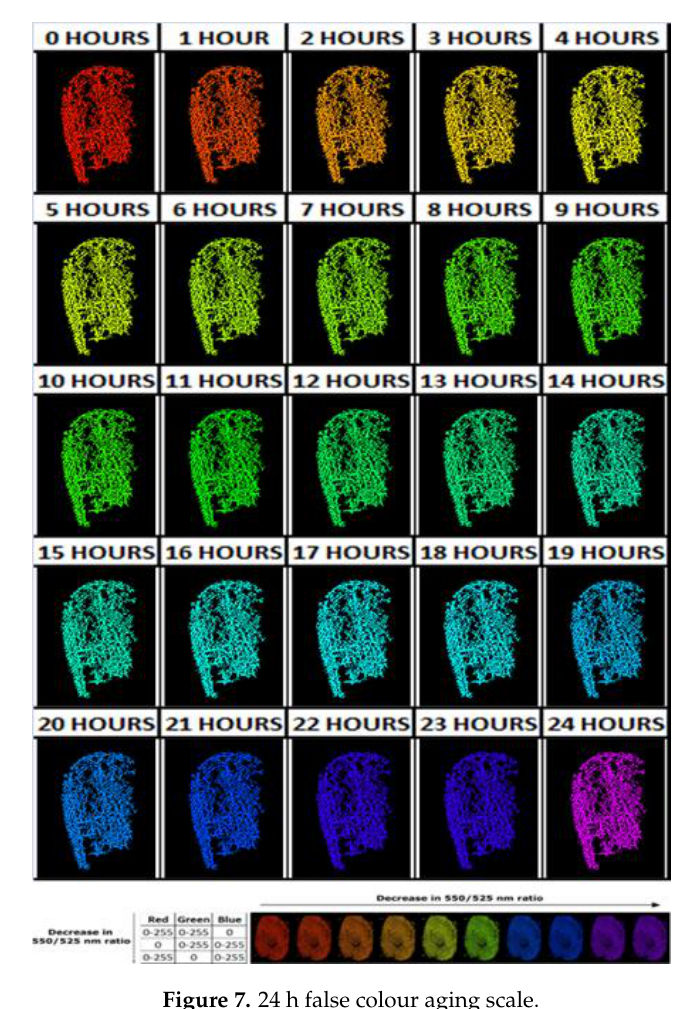
Figure 7. 24 h false colour aging scale.